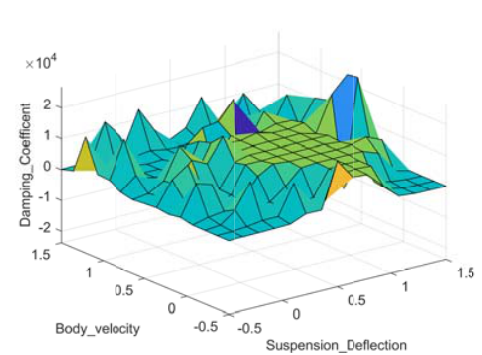
Figure 10. Surface view of ANFIS for i / p vs o / p